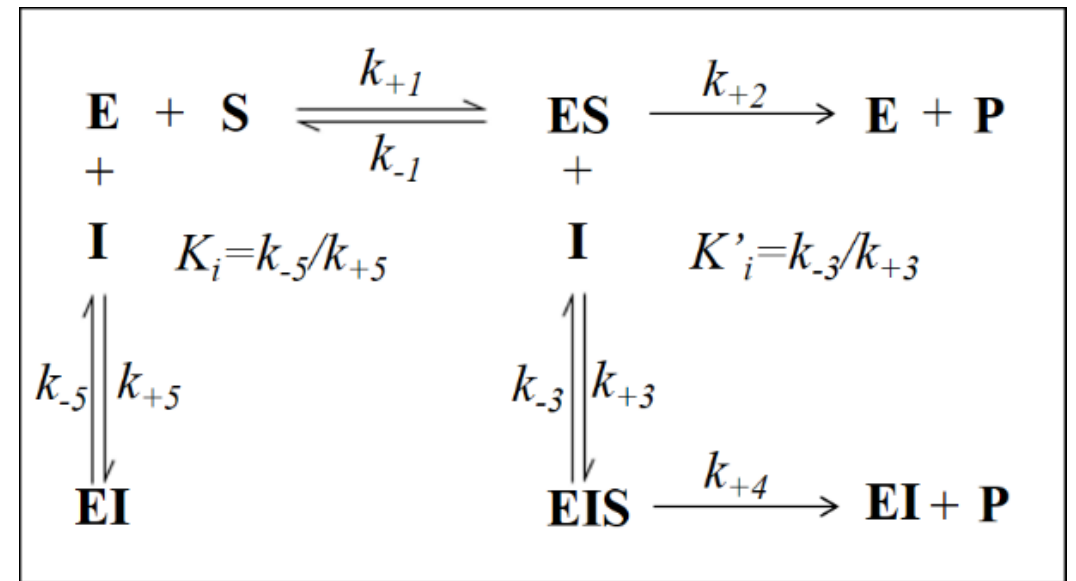
Figure 7. Classical model of incomplete enzyme inhibition when k +2 > k +4 > 0. E: enzyme; S: substrate; P: product; I: inhibitor; ES: enzyme-substrate complex; EI: enzyme-inhibitor complex; EIS: enzyme- inhibitor-substrate complex; k +1 , k − 1 , k +2 , k +3 , k − 3 , k +4 , k +5 , k -5 are the kinetic constants of the indicated re- actions.